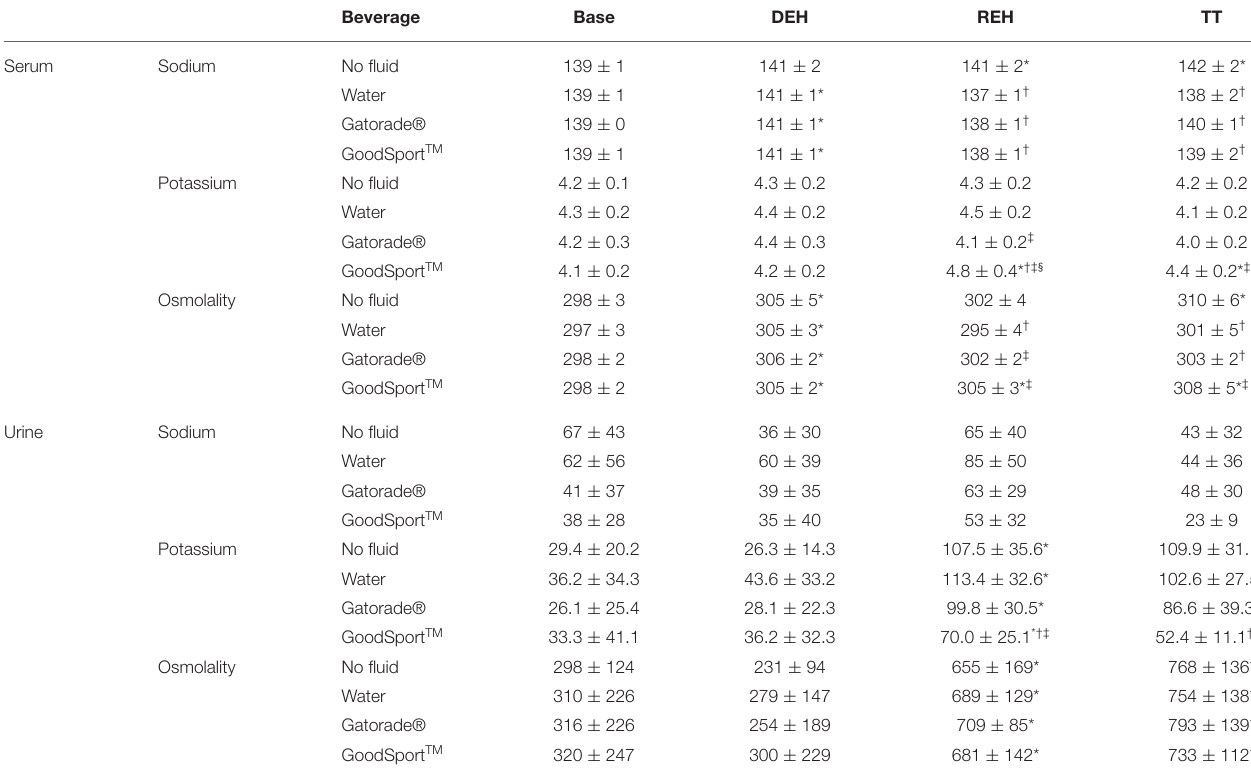
TABLE 5 | Serum and urine electrolyte concentrations and osmolality. Beverage Base DEH REH TT Serum